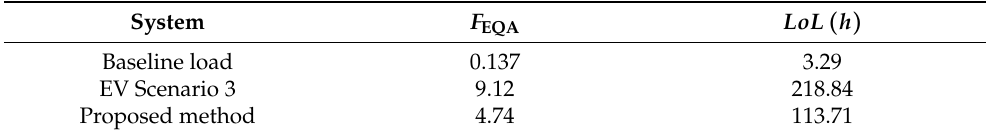
Figure 13. Transformer life indices in scenario 3, ( a ) hottest-spot temperature, θ H ; ( b ) accelerated aging factor, F AA . Table 6. F EQA and LoL in scenario